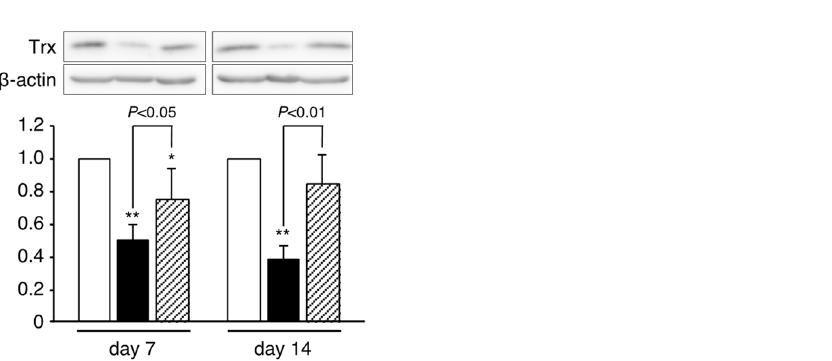
Figure 5. Effect of HSA-Trx on endogenous Trx expression in kidney of renal IR-treated mice. ( A ) Trx mRNA expression in kidney on 1, 7 and 14 days after renal IR were determined by real-time PCR. ( B ) Trx protein expression in kidney on 1, 7 and 14 days after renal IR, and ( C ) Trx protein expression in kidney on 7 and 14 days after renal IR with or without HSA-Trx treatment were assessed by Western blotting. The intensity of each band was quantified using the ImageJ software program and normalized against β -actin expression. Data are expressed as the mean ± SD ( n = 4). * p < 0.05, ** p < 0.01 compared with sham mice.